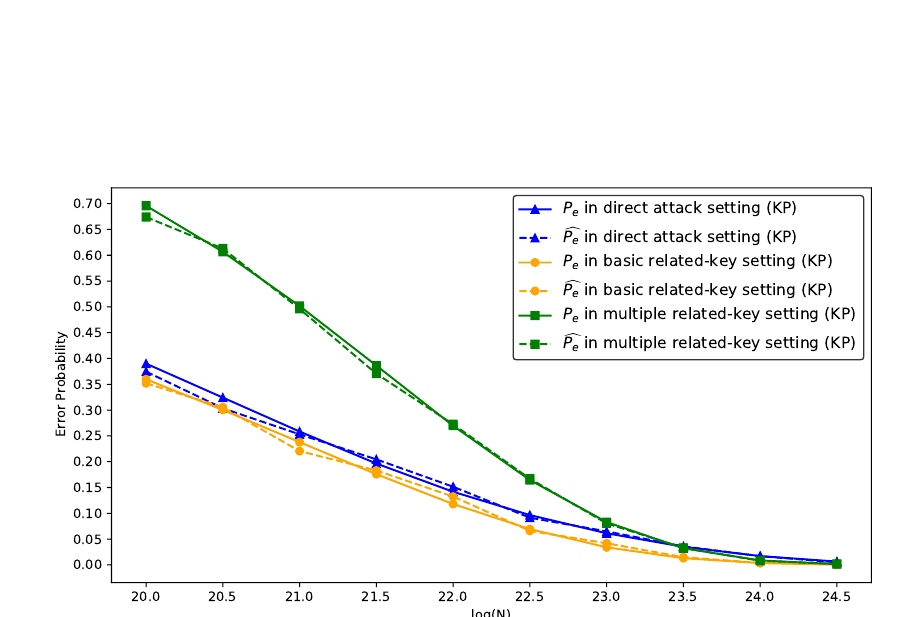
Figure 3: Comparison of error probabilities using the threshold-based models introduced in Sect. 3.1.